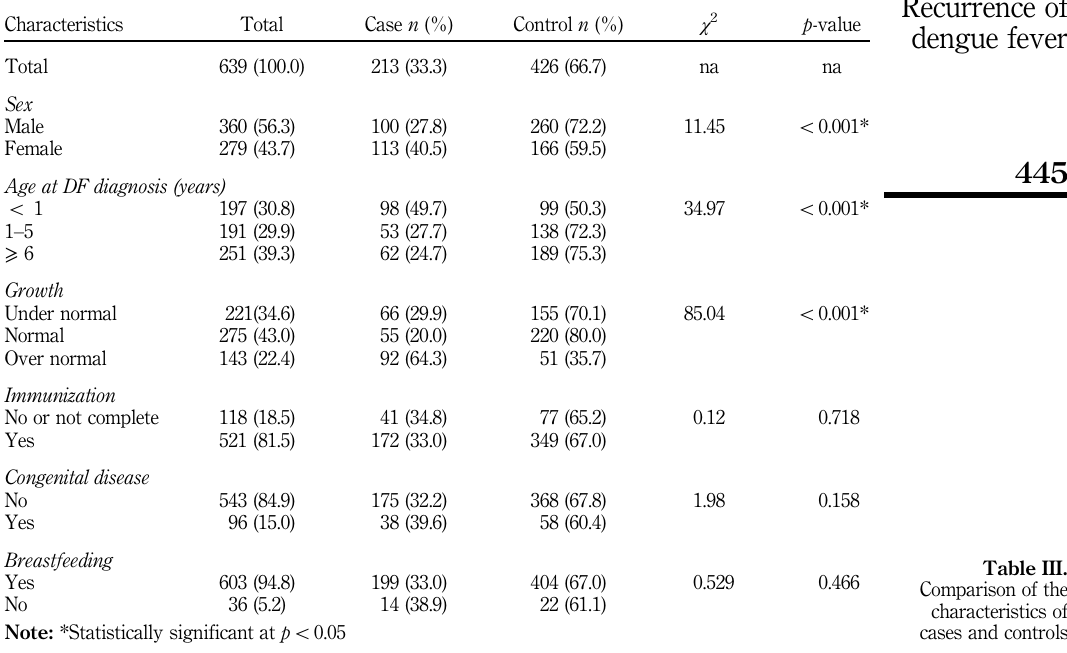
Table III. Comparison of